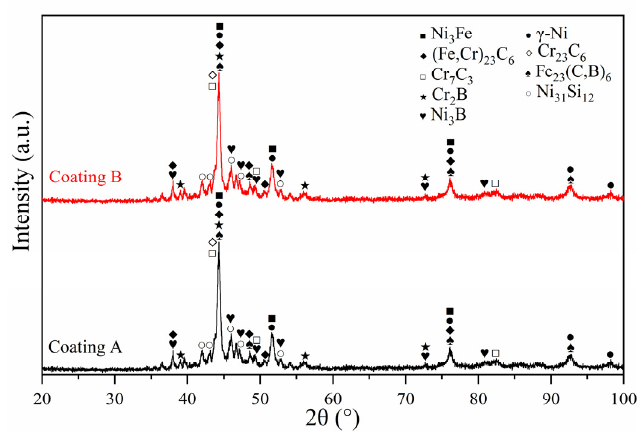
Figure 7. Comparative XRD patterns of coating A and coating B.